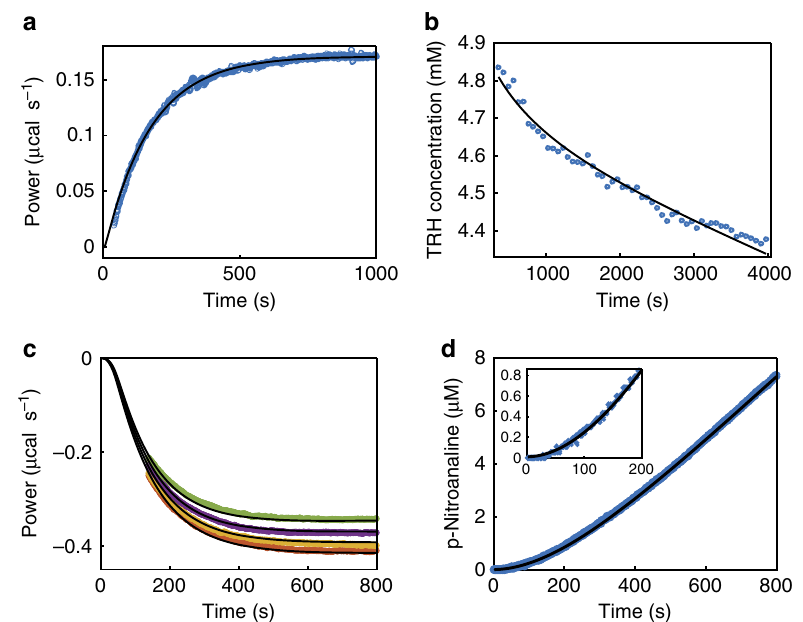
Fig. 3 Validation using absorbance spectroscopy and 1 H NMR. a Inhibition experiment with compound 5 using a Malvern ITC-200 calorimeter. Compound 5 is injected into the cell containing POP and TRH (blue circles). b Inhibition with compound 5 using NMR. Compound 5 is added to POP and TRH. Intensity of peak for TRH was used to calculate a concentration (blue circles). c Initiation experiment with compound 1 using a Malvern ITC-200 calorimeter. POP and compound 1 are injected into the cell containing TRH (second injection; orange circles, third injection; yellow circles, fourth injection; purple circles, and fi fth injection; green circles). d Initiation experiment with compound 1 using UV-Vis spectroscopy. POP and compound 1 are injected into buffer containing ZGP-pNA. The intensity of the peak at 405 nm was converted to a concentration of pNA (blue circles). Fits to experimental data are overlaid (black lines) using models presented in Supplementary